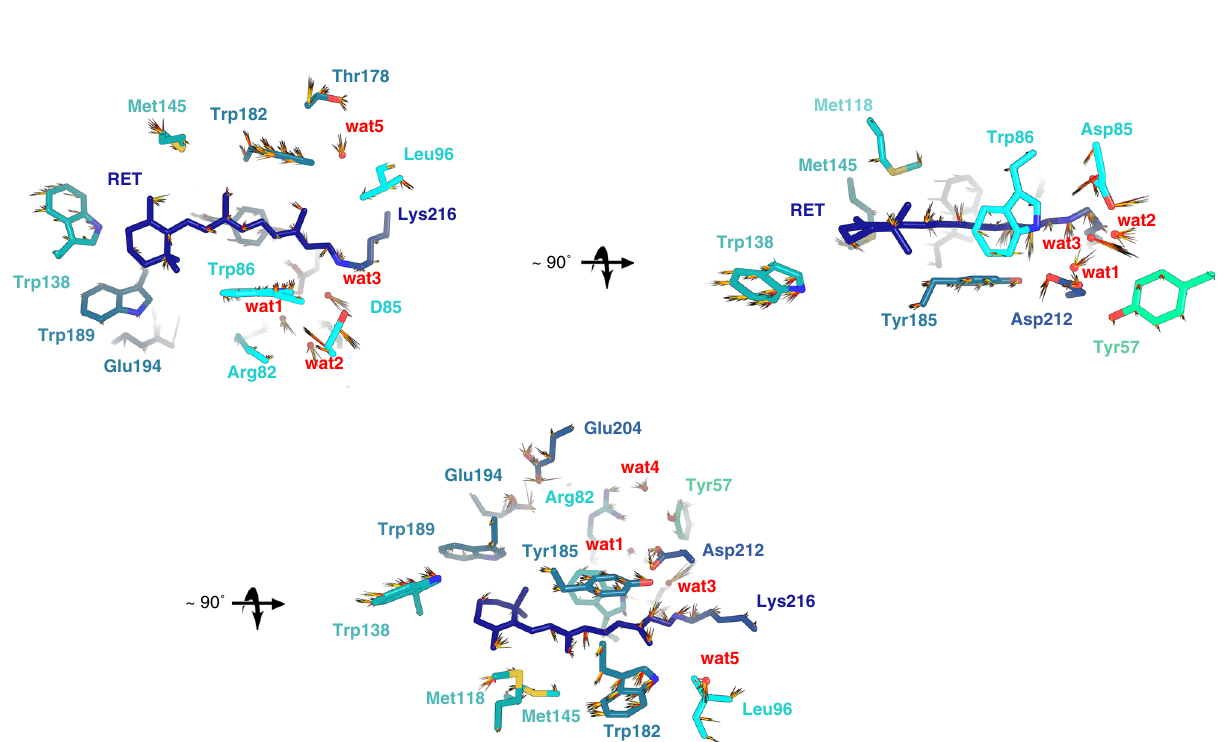
Fig. 8b – i as a Source Data fi